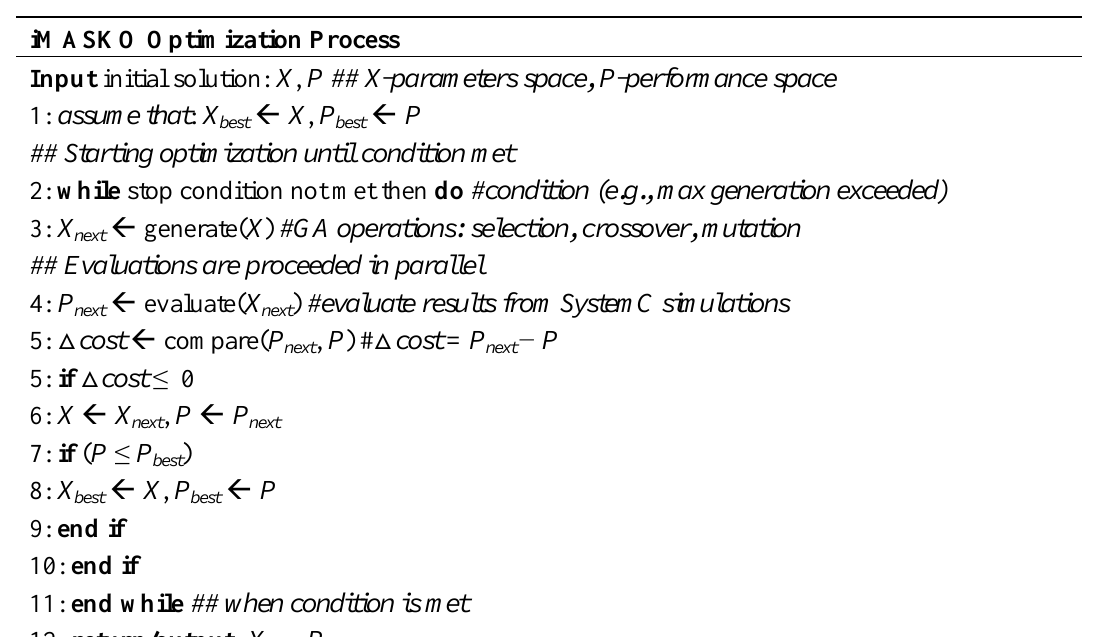
Table 2. Pseudo code of i NL@ M ATLAB G A -based S ensor Networ K O ptimizer (iMASKO) optimization